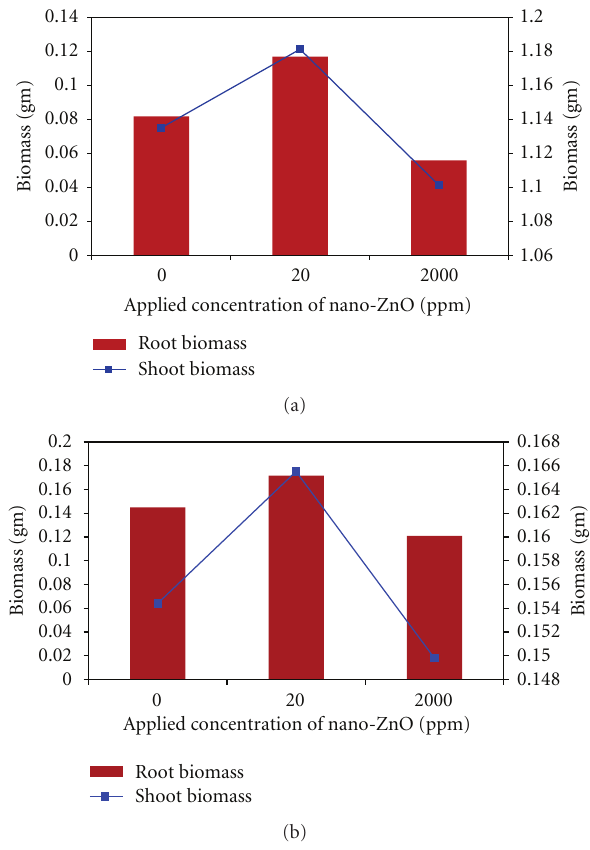
Figure 3: (a) Dry biomass of root and shoot of mung seedlings. (b) Dry biomass of root and shoot of gram